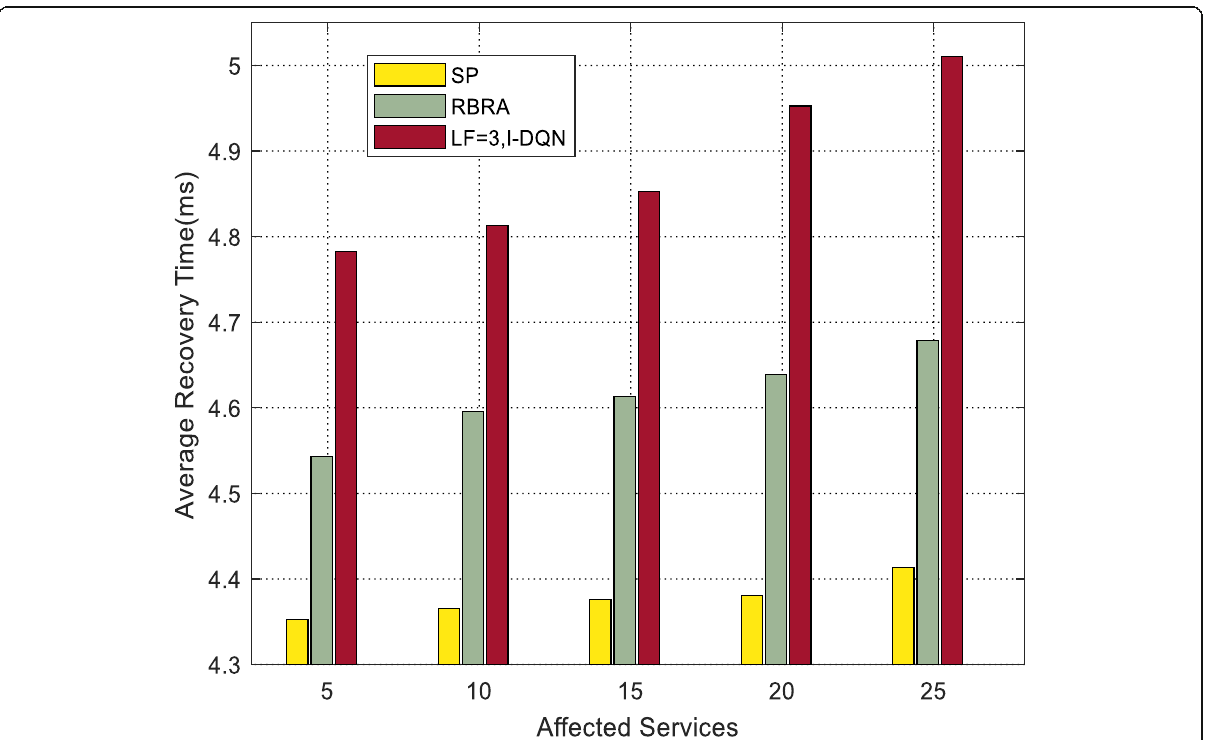
Fig. 12 Average recovery time vs. no. of affected services. This figure shows the average recovery time comparison in three schemes, SP, RBRA, and I-DQN, and LF =